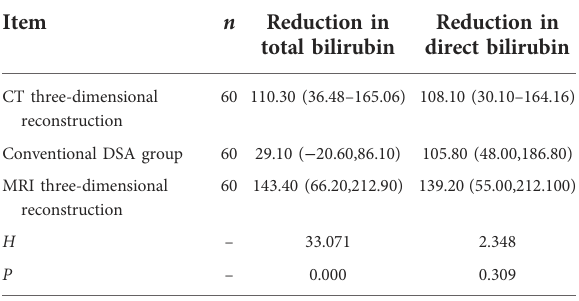
TABLE 2 Comparison of the reduction in the levels of bilirubin among the three groups [M(Q1, Q3), μ mol/L].